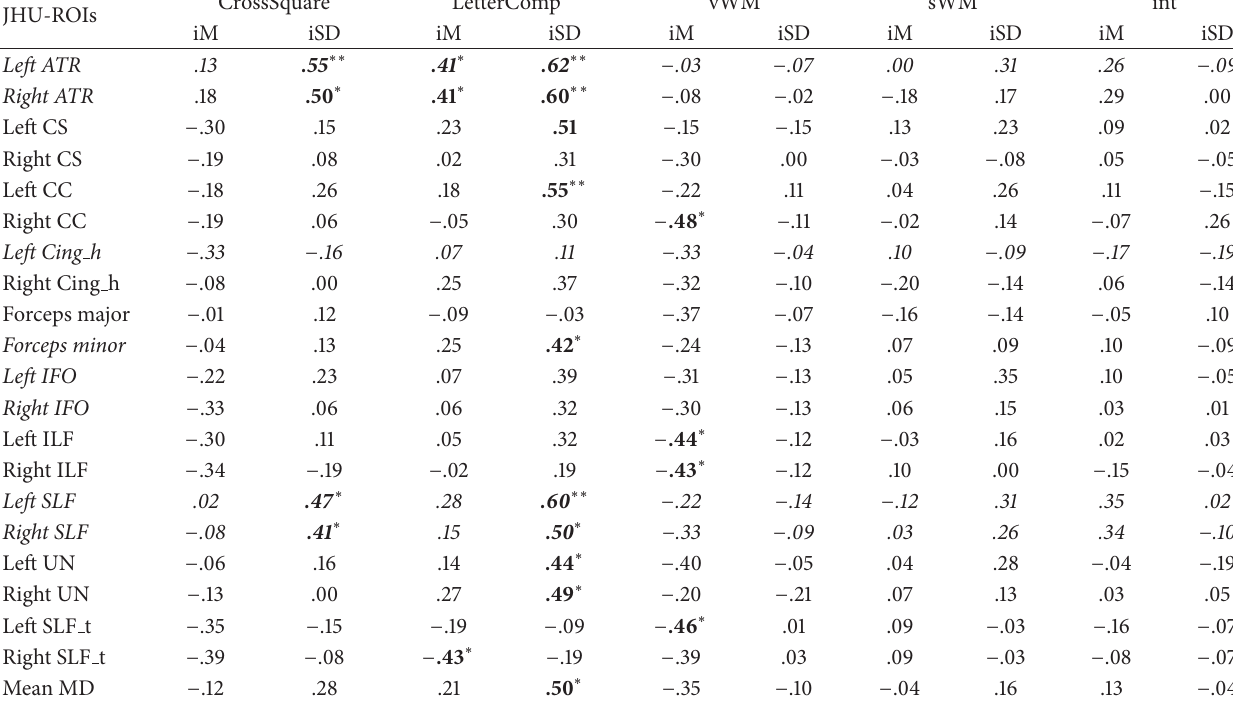
Table 4: Correlations between MD in the JHU-ROIs and cognitive